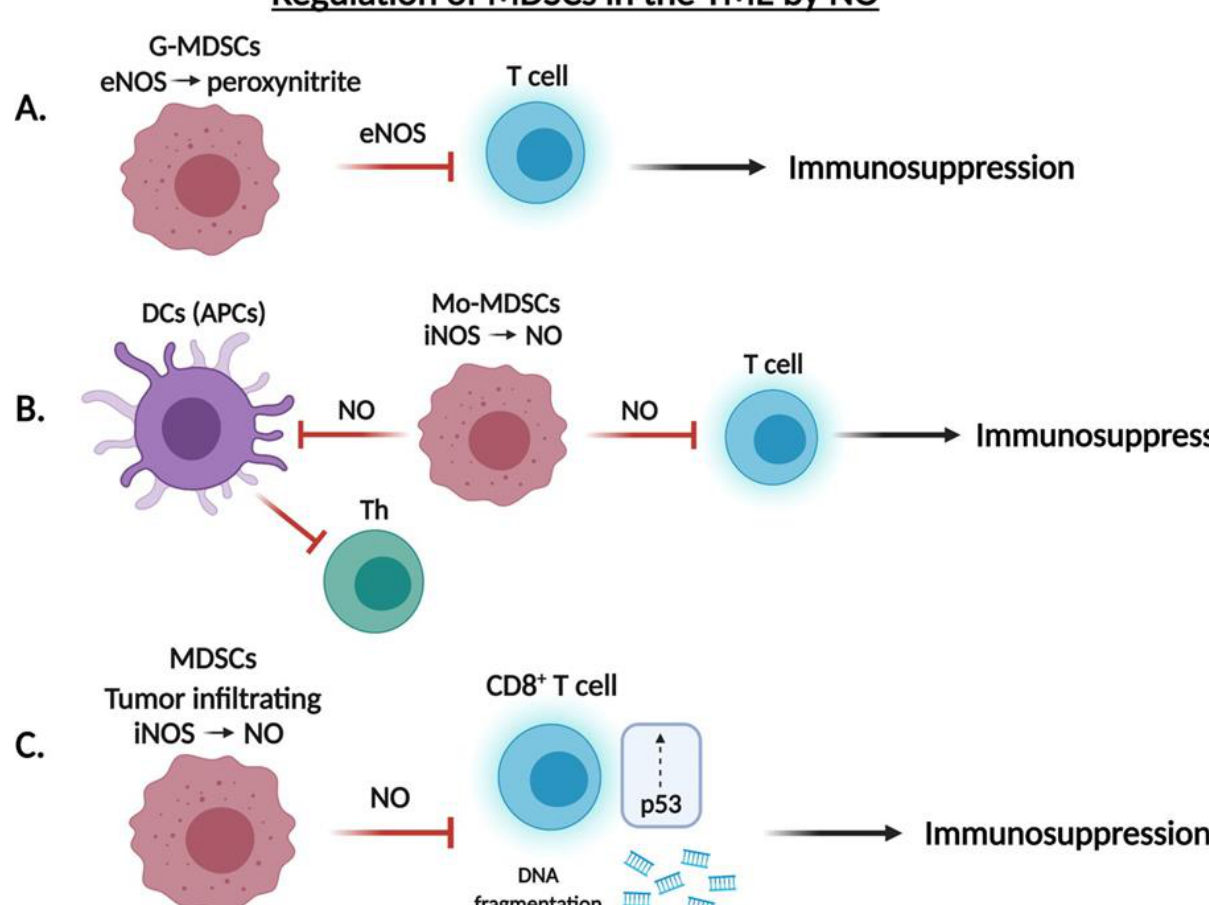
Figure 5. Regulation of MDSCs in the TME by .NO. ( A , B ) Granulocytic MDSC (G-MDSC) and monocytic MDSC (Mo-MDSC) inhibit T cell function via the eNOS-mediated generation of peroxynitrite and iNOS-mediated generation of .NO, respectively. ( C ) Tumor infiltrating MDSCs inhibit T cell function via DNA fragmentation and induction of the p53 pathway in CD8 + T cells via an iNOS-dependent